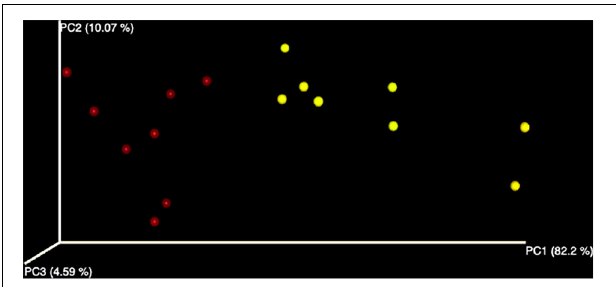
FIGURE 2 | Evaluation of beta diversity in field (red) and hydroponic (yellow) plants. The principal component analysis was performed using Quantitative Insights into Microbial Ecology